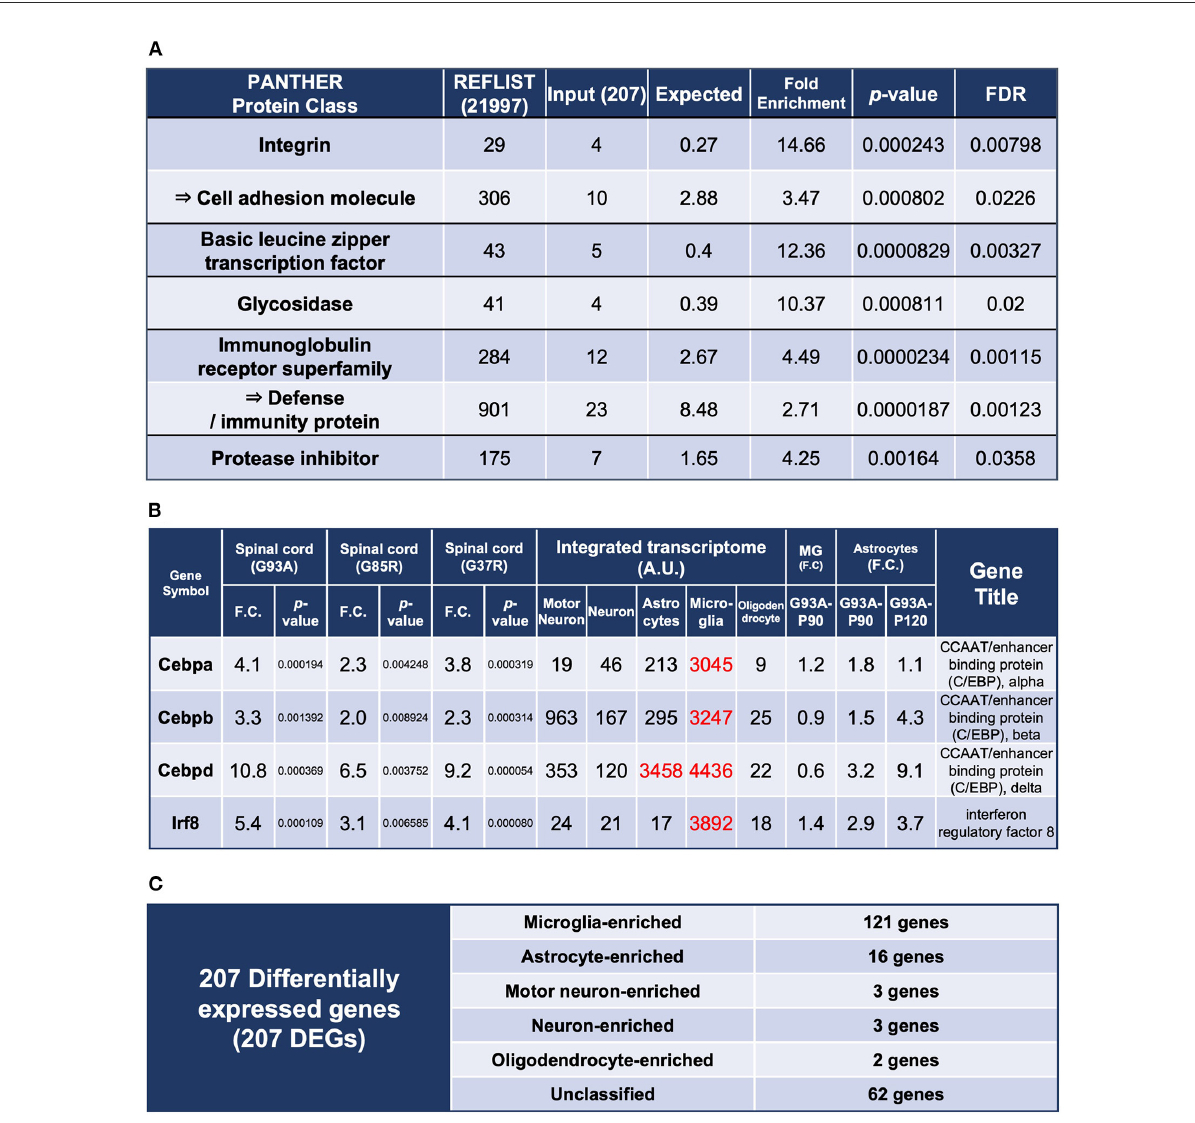
FIGURE2 Enrichment analysis using the 207 DEGs and classification of each of the 207 DEGs by cell types with high expression. (A) Enrichment analysis using the 207 DEGs as an input. The first column shows the name of the PANTHER classification category. The second column shows the number of genes in the reference list that map to this particular PANTHER classification category. The total number of genes in the reference list is 21,997. The third column shows the observed number of genes in our input list that map to this PANTHER classification category. The fourth column shows the expected value, which is the number of genes we would expect in our list for this PANTHER category, based on the reference list. The fifth column shows the fold enrichment, which is the ratio of the value of column 3 (input: observed number) over that of column 4 (expected number). The sixth column shows the raw p -values. The seventh column shows the q -value (adjusted p -value, reflecting the false discovery rate) as calculated by the Benjamini-Hochberg procedure. Cell adhesion molecule is in the parent category of integrin, so it is shown in the row below. Similarly, defense/immunity protein is the parent category of immunoglobulin receptor superfamily . Therefore, they are indicated with arrows. (B) Representative transcription factors in the 207 DEGs. Three CCAAT/enhancer binding proteins and interferon regulatory factor 8 are shown. (C) All of the 207 DEGs were classified into cell types in which each gene is highly expressed; Unclassified are the genes that are not highly expressed in one particular cell type. MG,